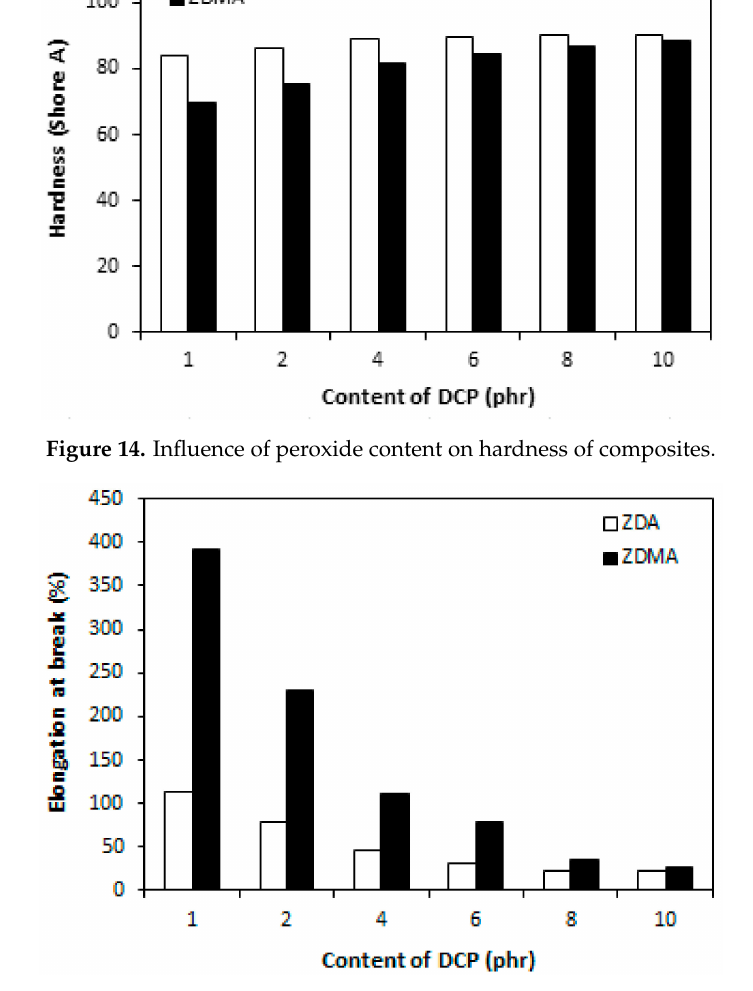
Figure 15. Influence of peroxide content on elongation at break of